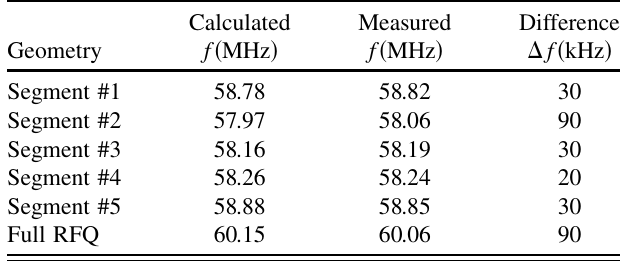
TABLE XIII. Comparison of calculated and measured fre- quencies for individual RFQ segments and the full RFQ. The calculations are performed using the tetrahedral